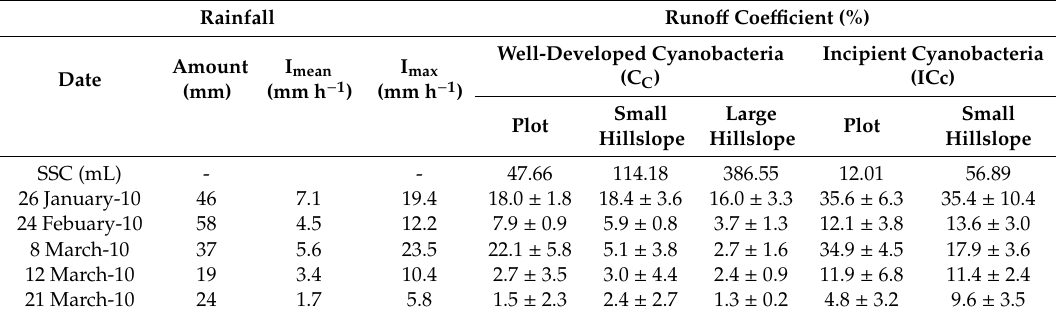
Table 2. Characteristics of rainfall events and runoff coefficients (mean ± SD, n = 3) measured in the plots with incipient and well-developed cyanobacterial biocrusts, at the different scales at El Cautivo site.